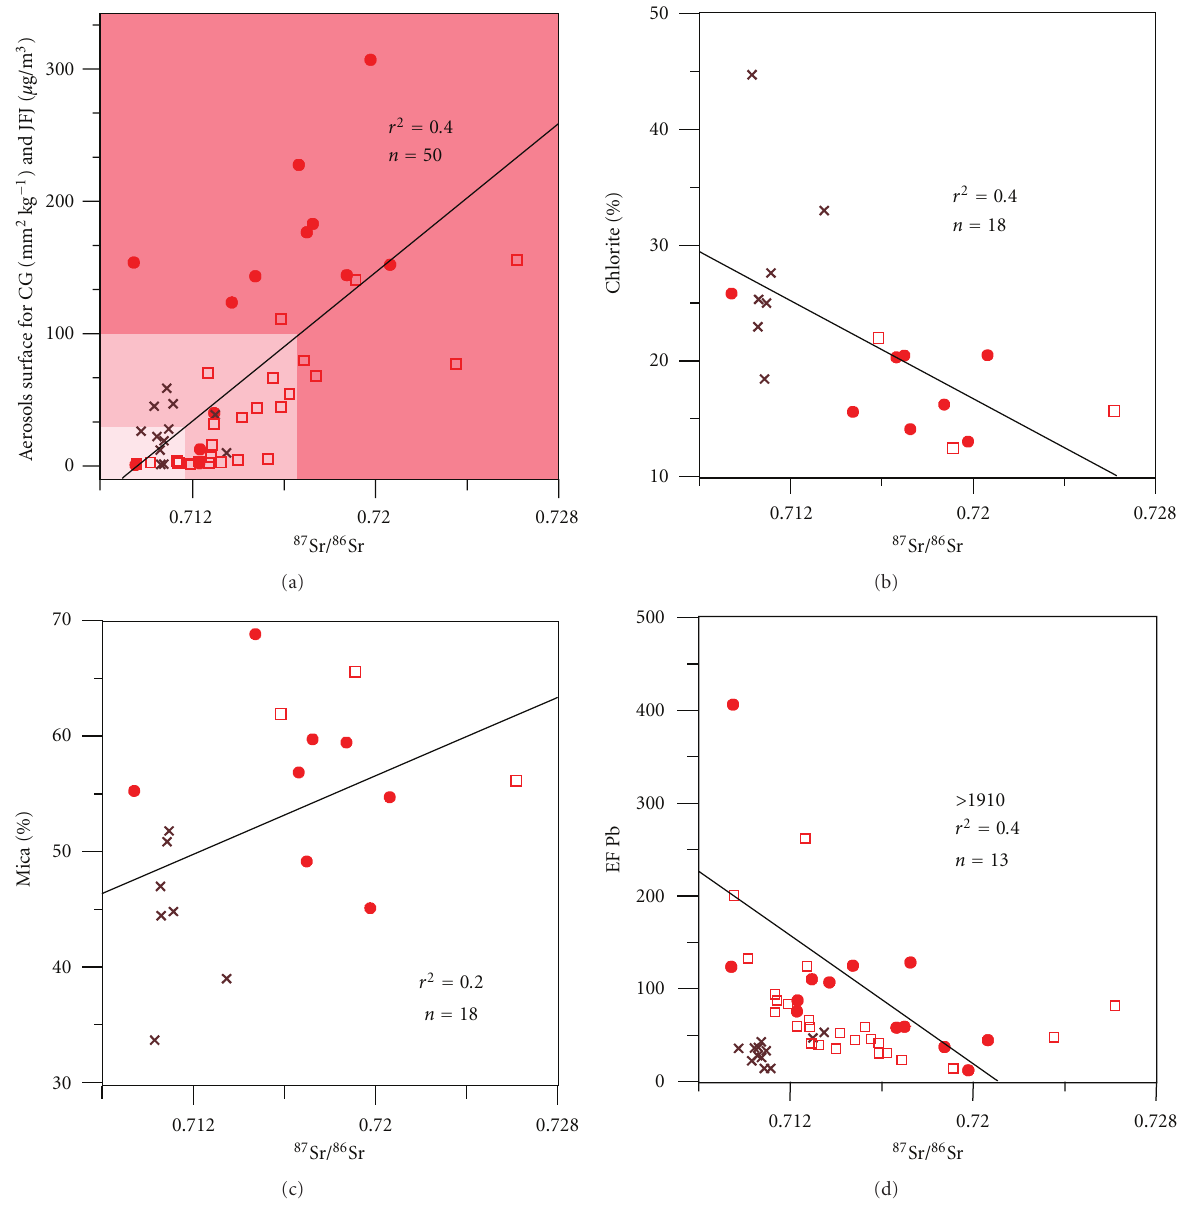
Figure 6: 87 Sr/ 86 Sr values as a function of the aerosol surface, the mica and chlorite contents, and the EF Pb for the Colle Gnifetti ice-core (CG, circles) and Jungfraujoch samples (JFJ, crosses). Pre-1910 CG samples are represented by empty squares, whereas post-1910 samples are represented by filled circles. Correlation coe ffi cients are calculated over the entire dataset (CG record and JFJ samples), except for EF Pb (CG samples after 1910). The color-shaded areas correspond to the aerosol surface classes of Figure 3 ( < 30 and > 100 mm 2